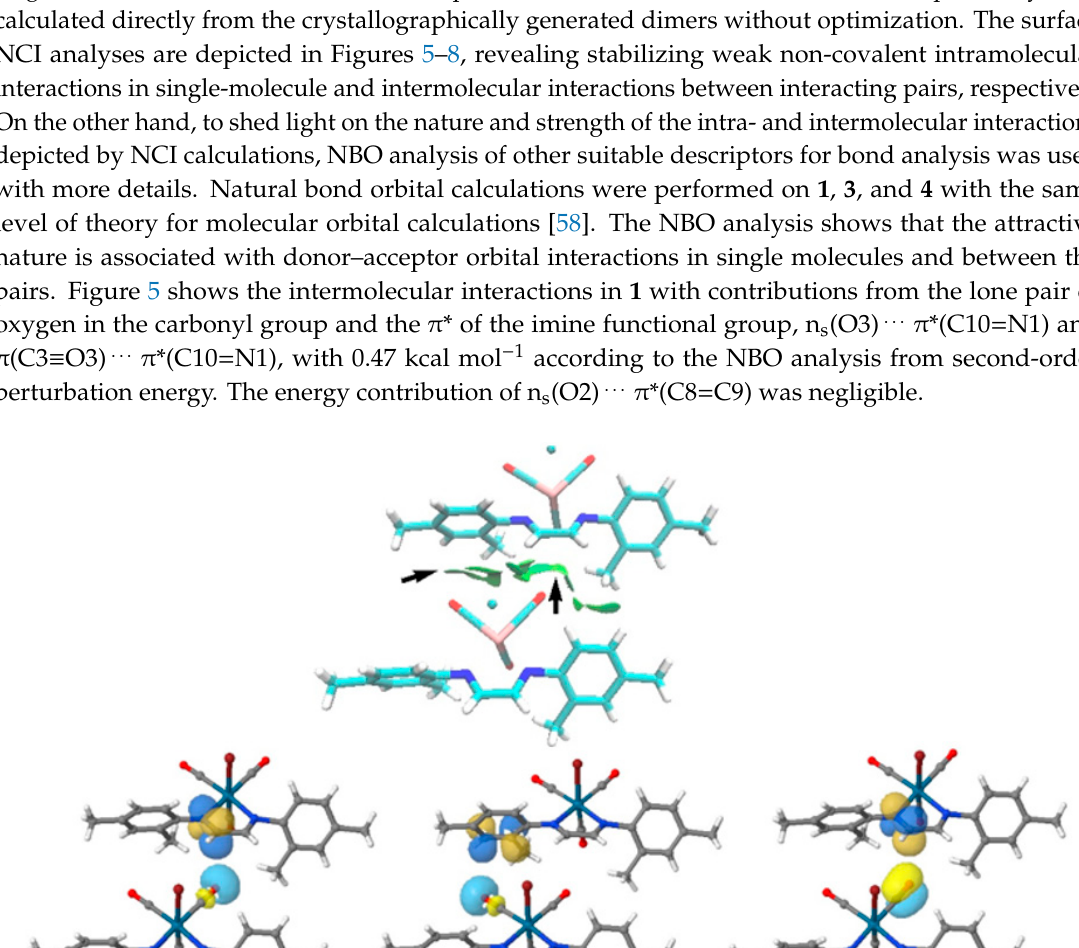
Figure 6. NCI plot of 3 and the representation of interacting donor–acceptor n s (Br) … σ *(CH), A – B ; n p (Br) … σ *(CH), C – H ; σ (CH) … π *(CO), I – L ; orbitals from NBO calculations.